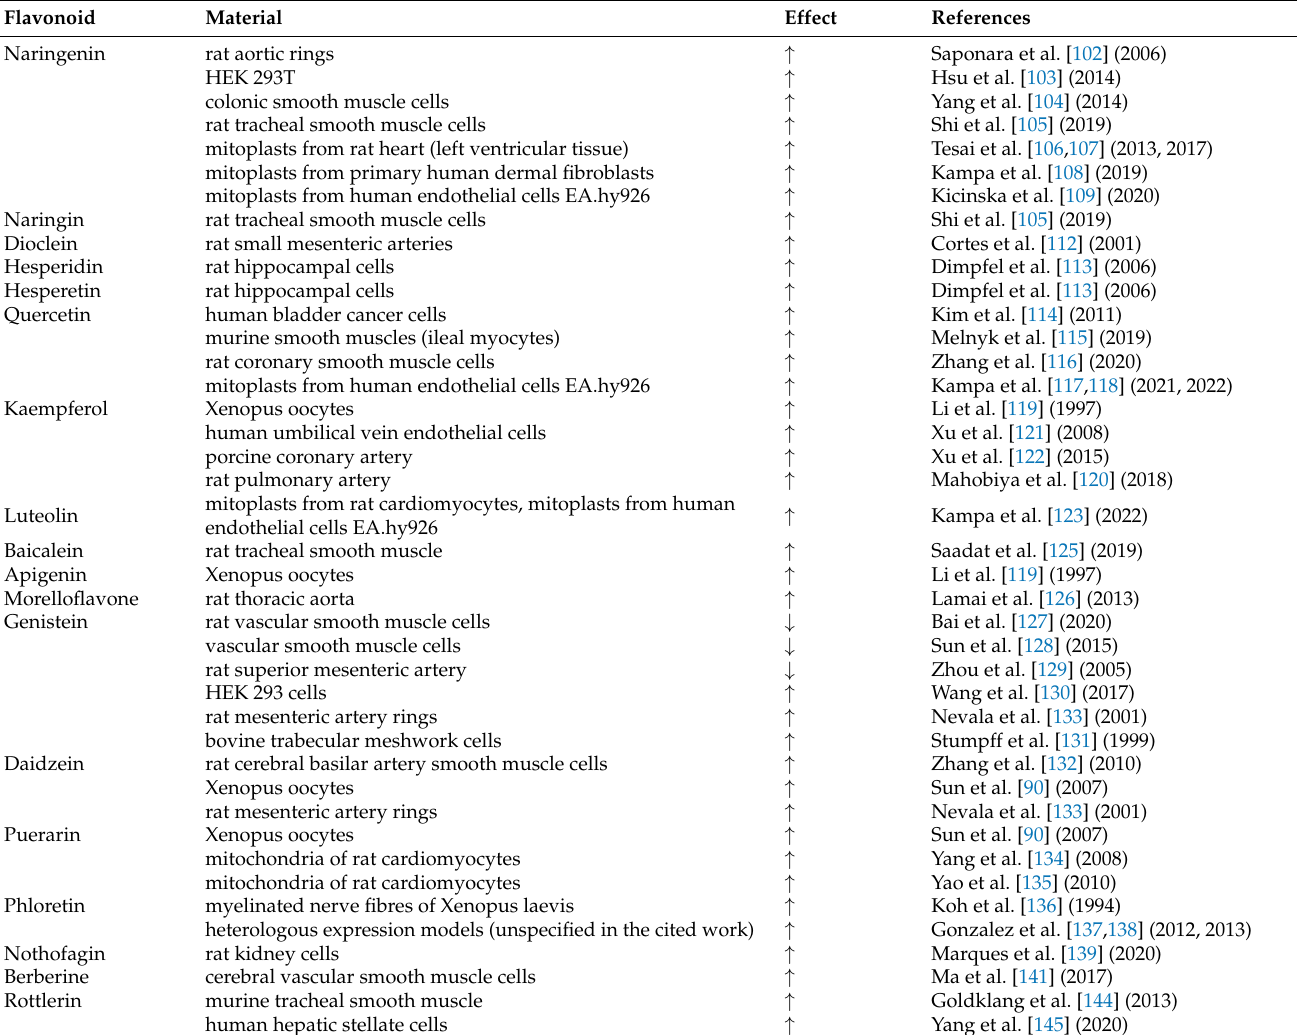
Table 3. The effects of different flavonoids on the activity of BK channels’ isoforms in different cell types. The ↑ represents channel activation, and ↓ denotes channel inhibition. The table includes the effects of berberine, which does not strictly belong to the flavonoid family. Nevertheless, by some authors, it is categorized as ’isoquinoline